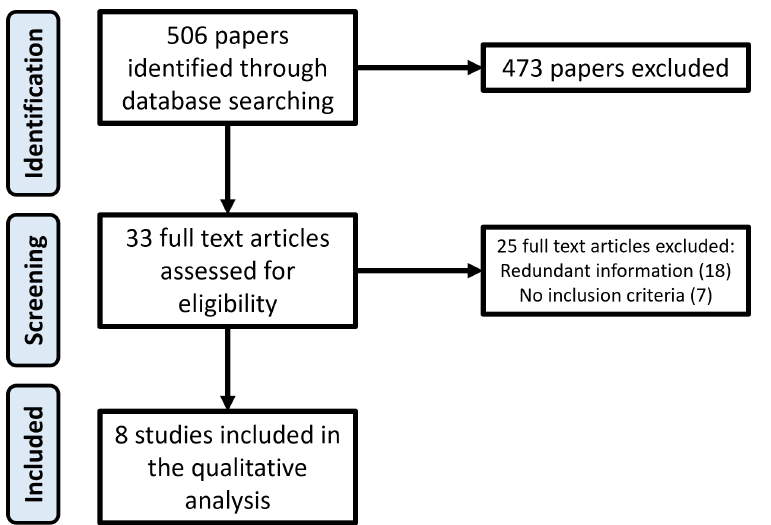
Figure 1. Flowchart of the search and inclusion